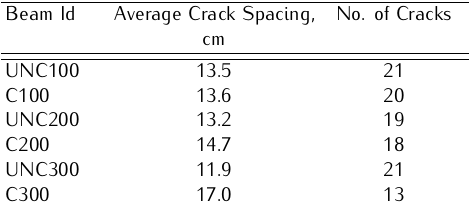
Table 4. Number of cracks and average spacing of